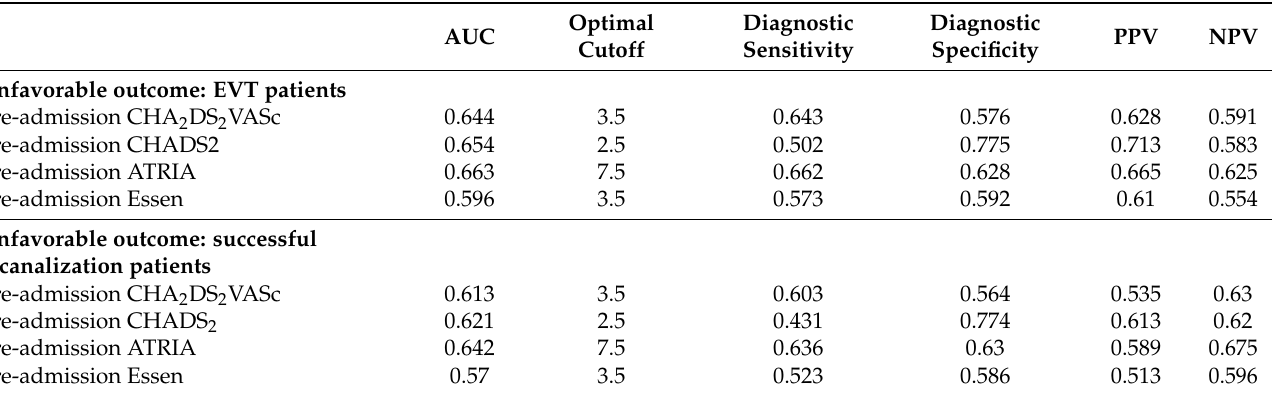
Table 3. Receiver operating characteristic curve analysis of risk scores for the probability of a functional outcomes. Optimal Diagnostic AUC Cutoff